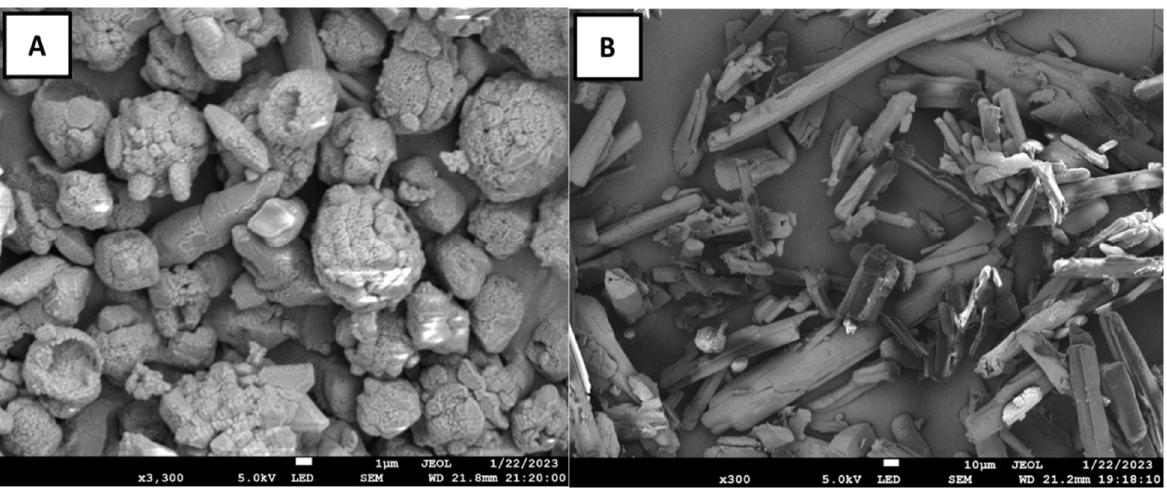
Figure 3. SEM characterization of mannose derivatives. ( A ) 4-NMBA and ( B ) 4-TNM.3.5. NMR Figure Characterization.